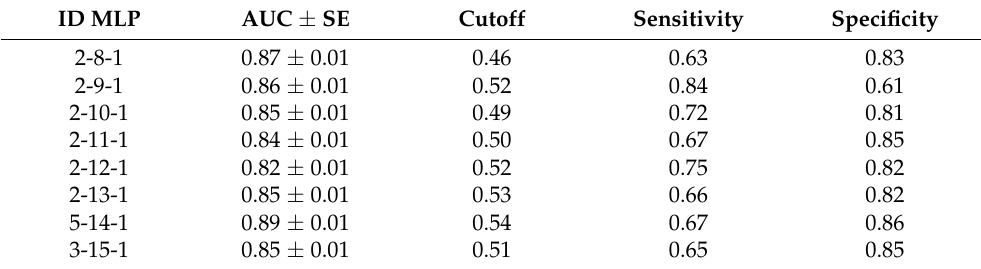
Table 6. Diagnostic criteria of AUC under the ROC curve, sensitivity and